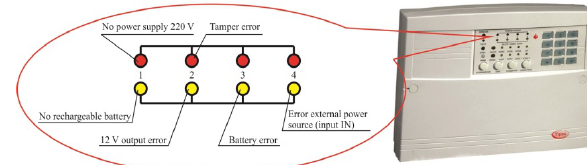
Figure 1. Extended power failure indication FACIE "Tiras-4P"